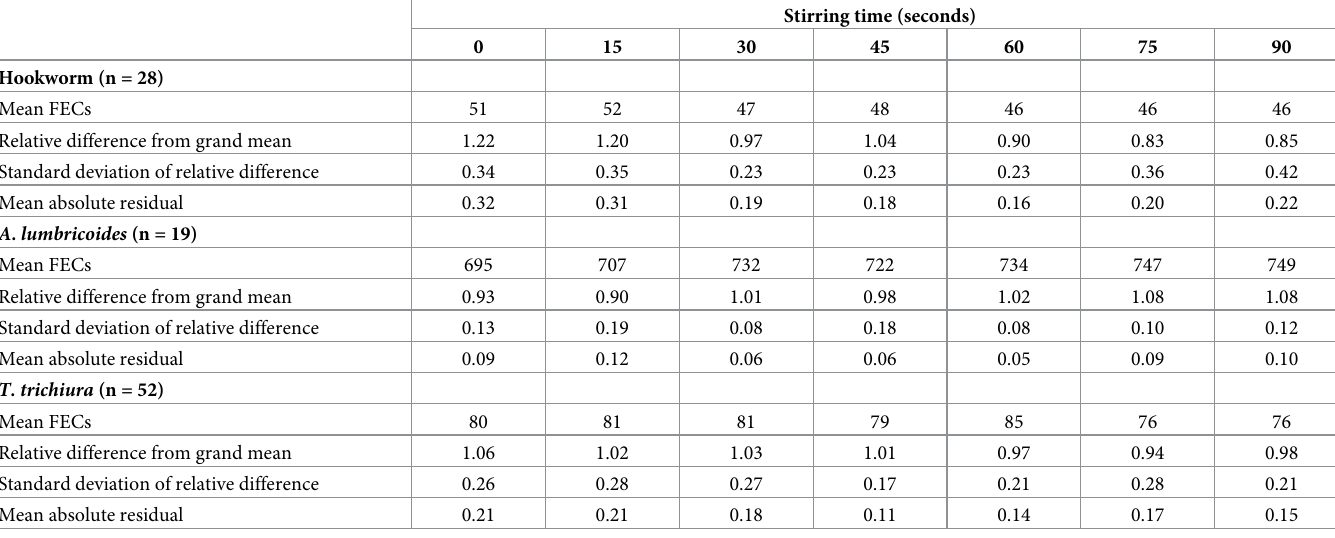
With increasing rounds of stirring, mean FECs decreased in samples with hookworm eggs (n = 28; Fig 6A and Table 4). For A . lumbricoides (n = 19) we observed a slight increase in mean FECs with every 15 seconds of extra stirring, whereas FECs in T . trichiura samples (n = 52) remained constant (Fig 6B and 6C and Table 4). The statistical analysis of the residuals showed a statistically significant reduction of variation of FECs for hookworm samples (change in residuals per 15 seconds: -0.02, 95% CI: -0.03 to -0.007, p = 0.004) and T . trichiura samples (change per 15sec: -0.01, 95% CI: -0.02 to -0.002, p = 0.01), but not for A . lumbricoides samples (change per 15sec: -0.001, 95%CI: -0.007 to 0.005, p = 0.66). The graphical inspection Table 4. Homogenizing experiment: Mean fecal egg counts (FECs), mean relative differences from the grand mean FECs per sample (over 7 observations), standard deviation of the relative differences and mean values of the residuals estimated from the random effect regression model. A . lumbricoides = Ascaris lumbricoides , T . trichiura = Trichuris trichiura